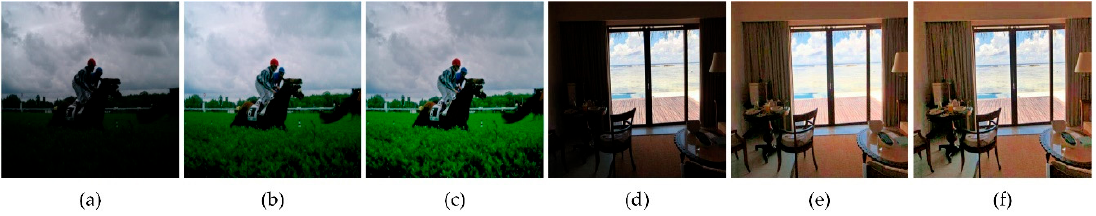
Figure 10. Effect of LSAGC. ( a , d ) Original images. ( b , e ) Enhanced images without LSAGC. ( c , f ) Enhanced images with LSAGC.